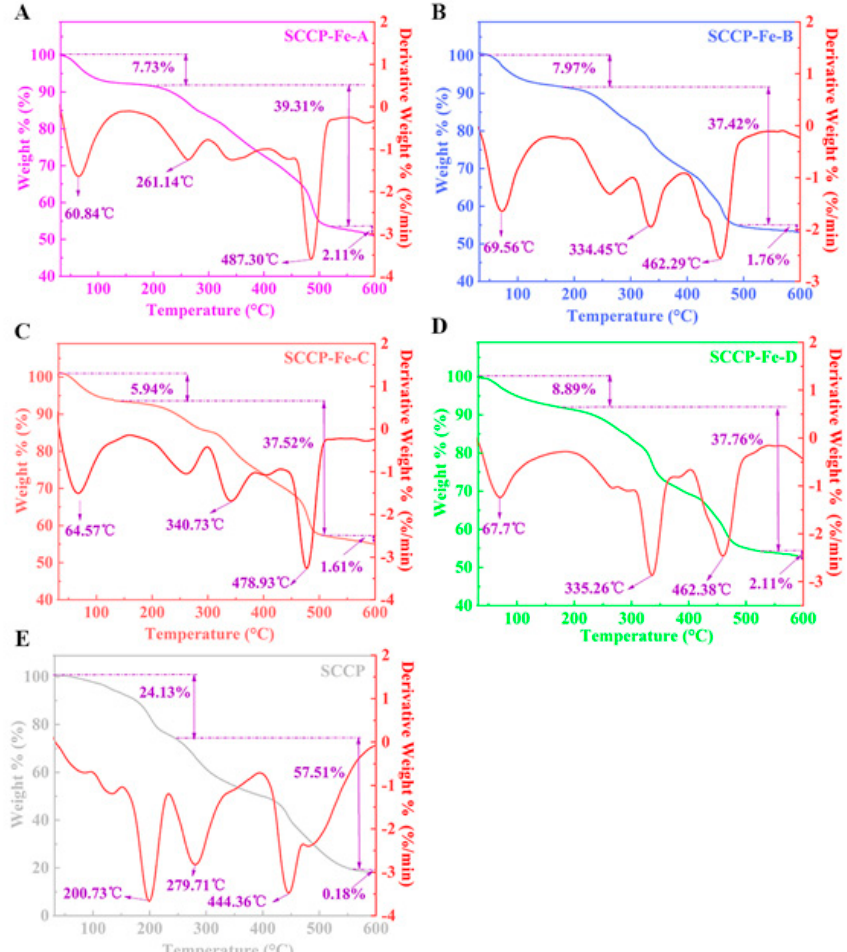
Figure 5. Thermal gravimetric analysis of four sweet corn cob polysaccharide-iron (III) complexes and SCCP (( A ): SCCP-Fe-A; ( B ): SCCP-Fe-B; ( C ): SCCP-Fe-C; ( D ): SCCP-Fe-D; ( E ): SCCP).